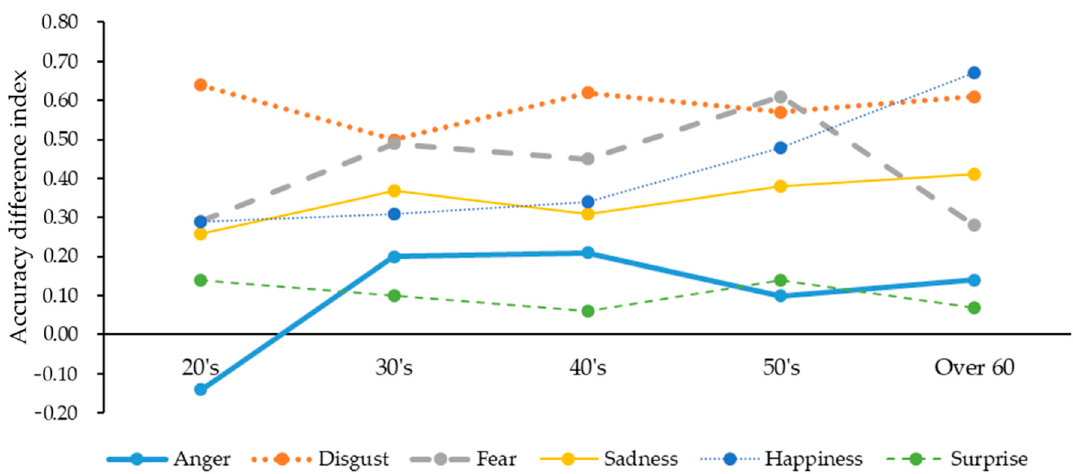
Figure 1. Graphs for participants’ age-related difference in accuracy difference indexes.